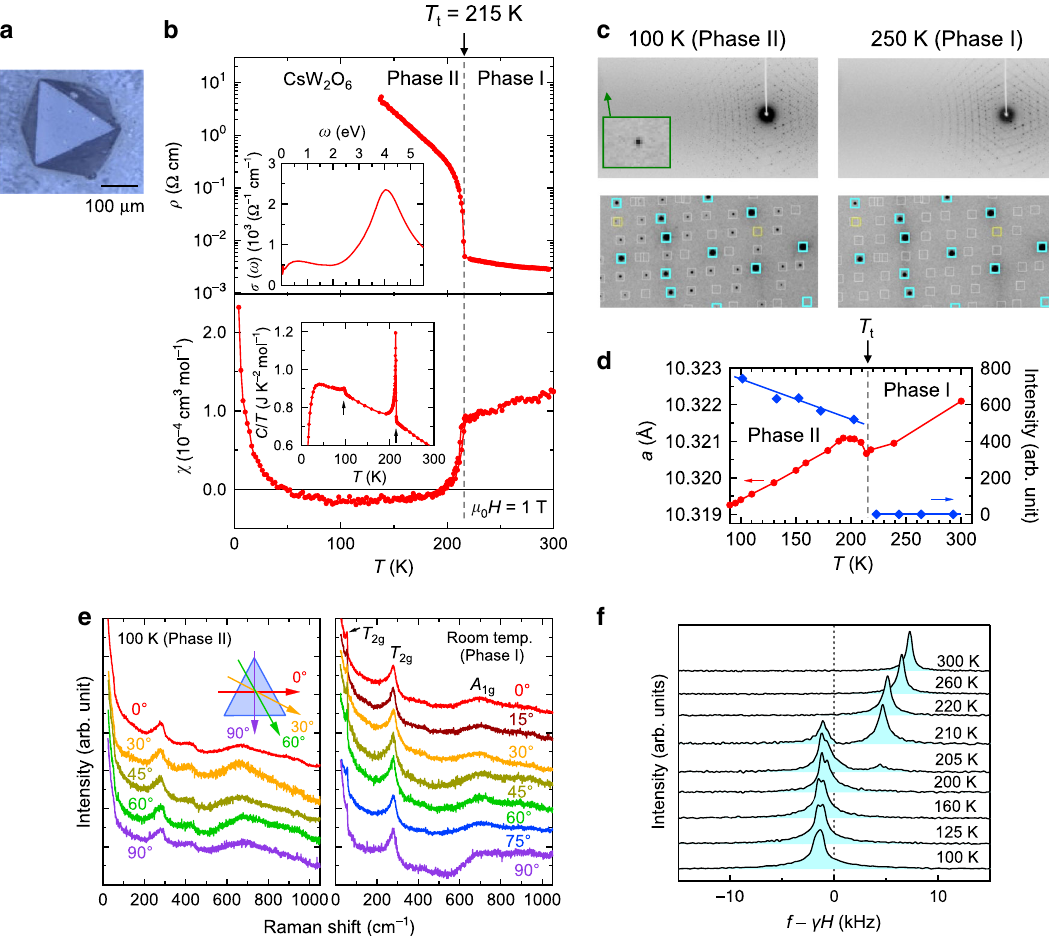
Fig. 1 Physical and structural properties of CsW 2 O 6 . All the experimental data in this fi gure except for the heat capacity were obtained using single crystals. a A single crystal of CsW 2 O 6 . b Temperature dependence of the electrical resistivity (upper) and magnetic susceptibility (lower). The inset of the upper panel shows the optical conductivity at room temperature deduced from the re fl ectivity using the Kramers – Kronig transformation 40 . The inset of the lower panel shows the heat capacity divided by temperature measured by using a polycrystalline sample. c Single-crystal XRD patterns at 250 (Phase I, right) and 100 K (Phase II, left). The pale blue and white squares indicate the positions of allowed and forbidden re fl ections, respectively, for the Fd (cid:1) 3 m space group. d Temperature dependence of the lattice constant and intensity of ( − 2, − 5, − 3) re fl ection estimated with the single-crystal XRD data. e Polarization dependence of the (111) Raman spectra measured at room temperature (Phase I, right) and 100 K (Phase II, left). f Temperature dependence of the 133 Cs-NMR spectra measured in a magnetic fi eld of 8 T applied along